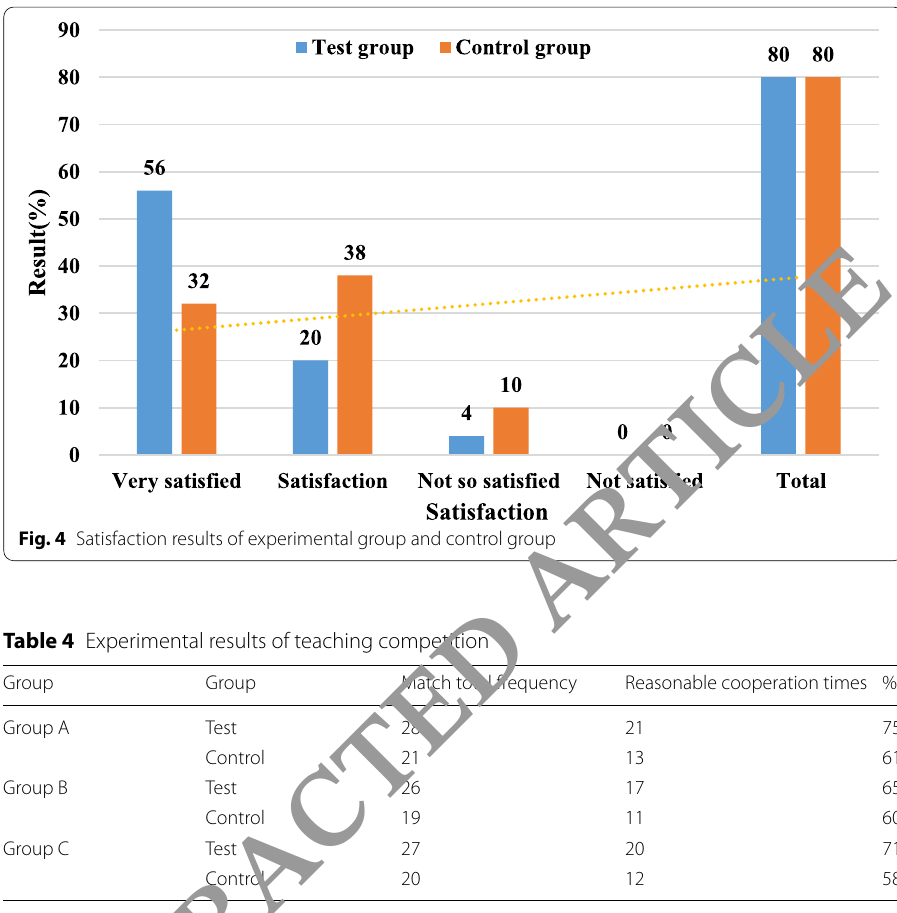
Fig. 4 Satisfaction results of experimental group and control group